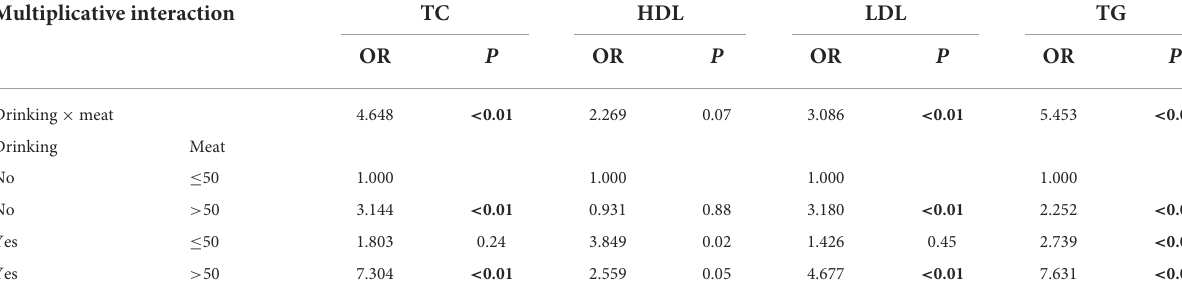
TABLE 4 Multiplicative interaction effects in the logistic regression